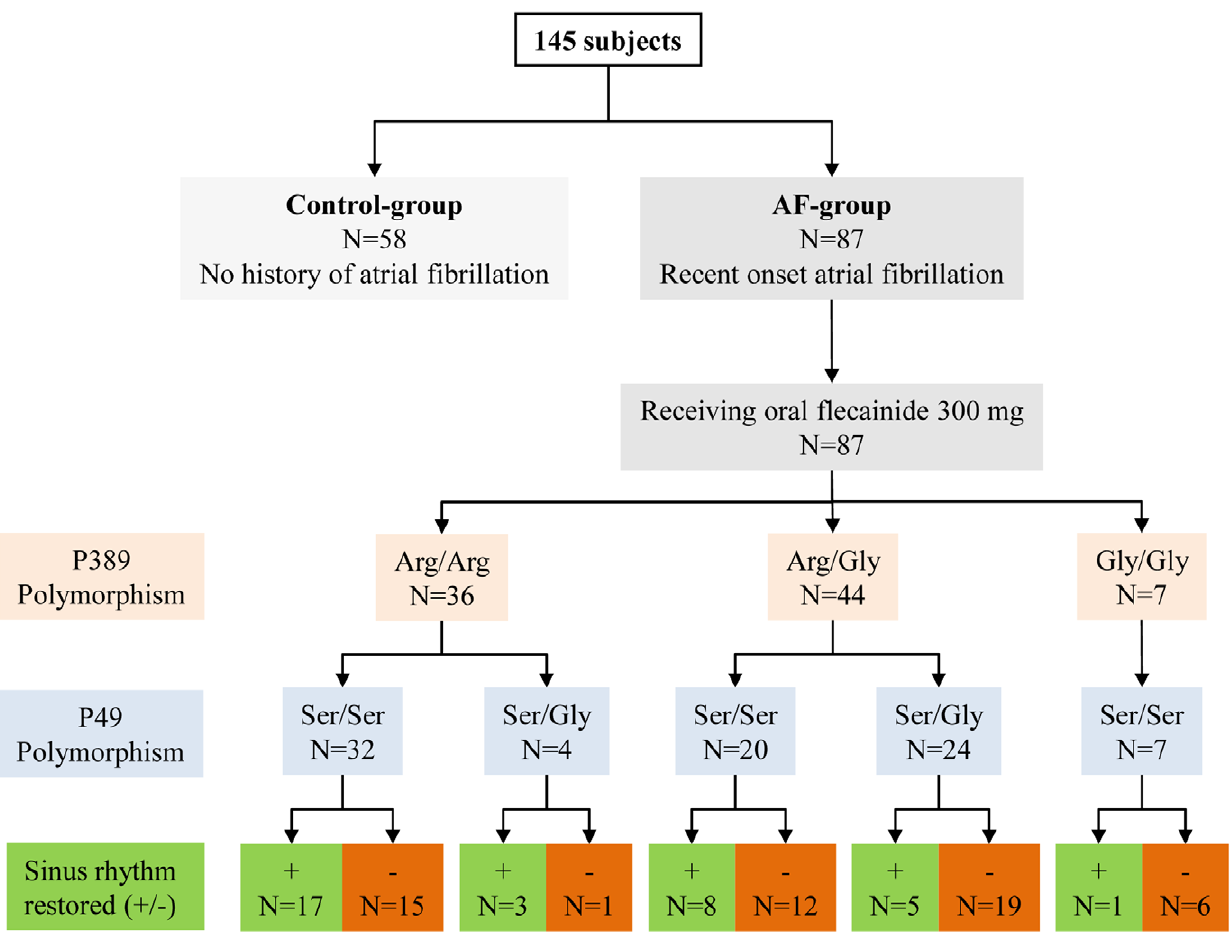
Figure 1. Study flow chart. Allele frequencies of different SNPs at position 389 and 49. The Gly49Gly variant was not present in any patient. All seven patients with Gly389Gly were homozygous for Ser49Ser.